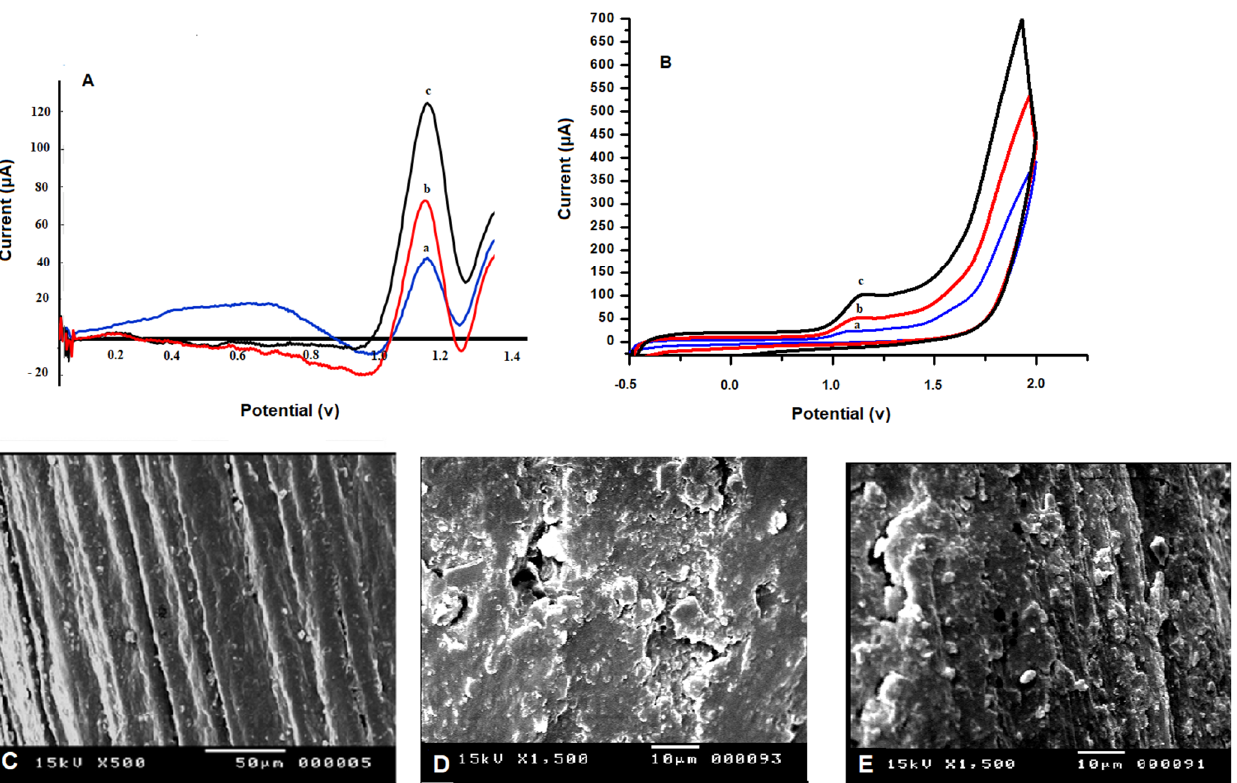
Figure 2. ( A ) SWVs, ( B ) CVs curves of FAV (70 × 10 −9 M) recorded on: (a) bare PGE, (b) poly m- THB/PGE and (c) Tb NPS @ poly m-THB/PGE & SEM images of: ( C ) bare PEG, ( D ) poly m-THB/PGE, and ( E ) Tb NPS @ poly m-THB/PGE surface.